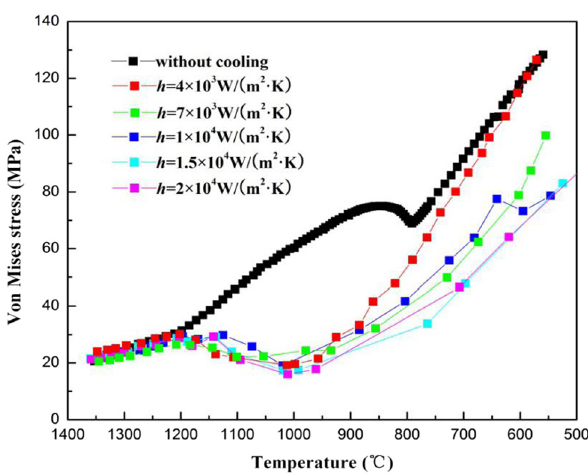
Figure 10: E ff ect of cooling intensity on the transient von Mises